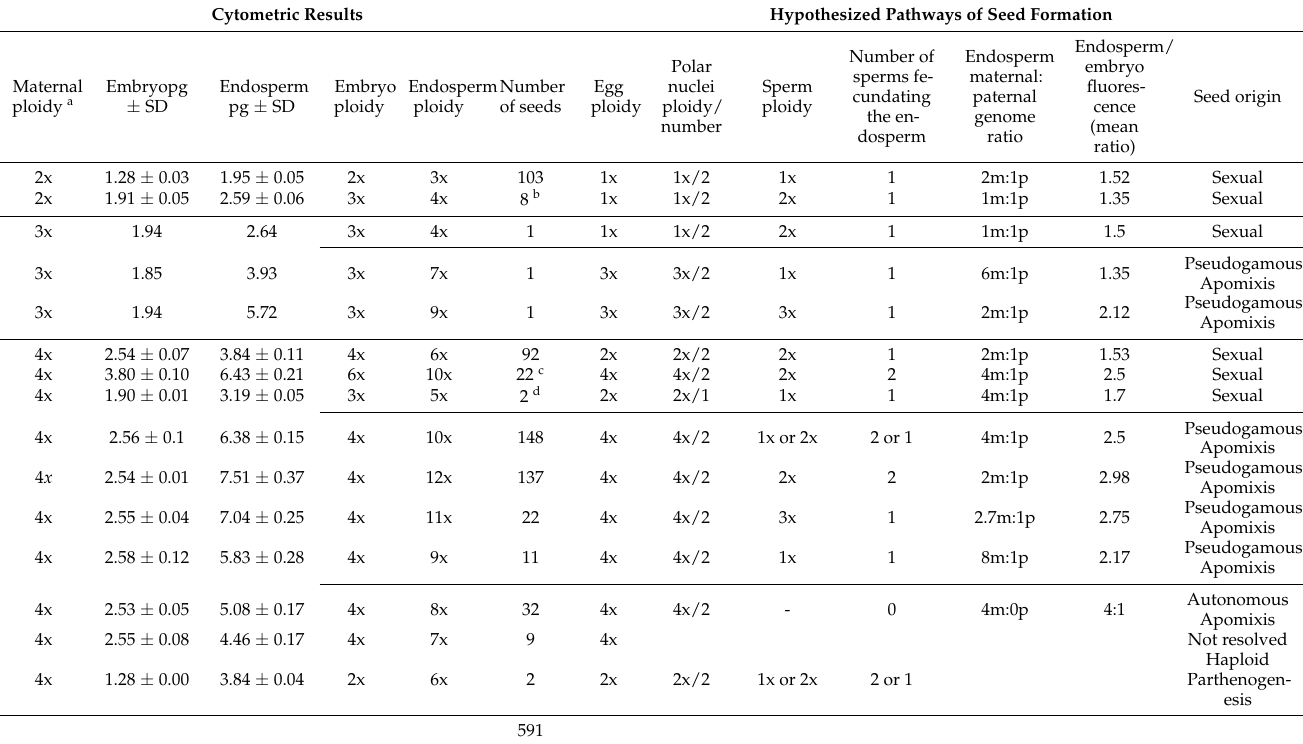
Table 3. Flow cytometric seed screening results and hypothesized pathways of seed formation and reproduction modes in analyzed Cotoneaster integerrimus